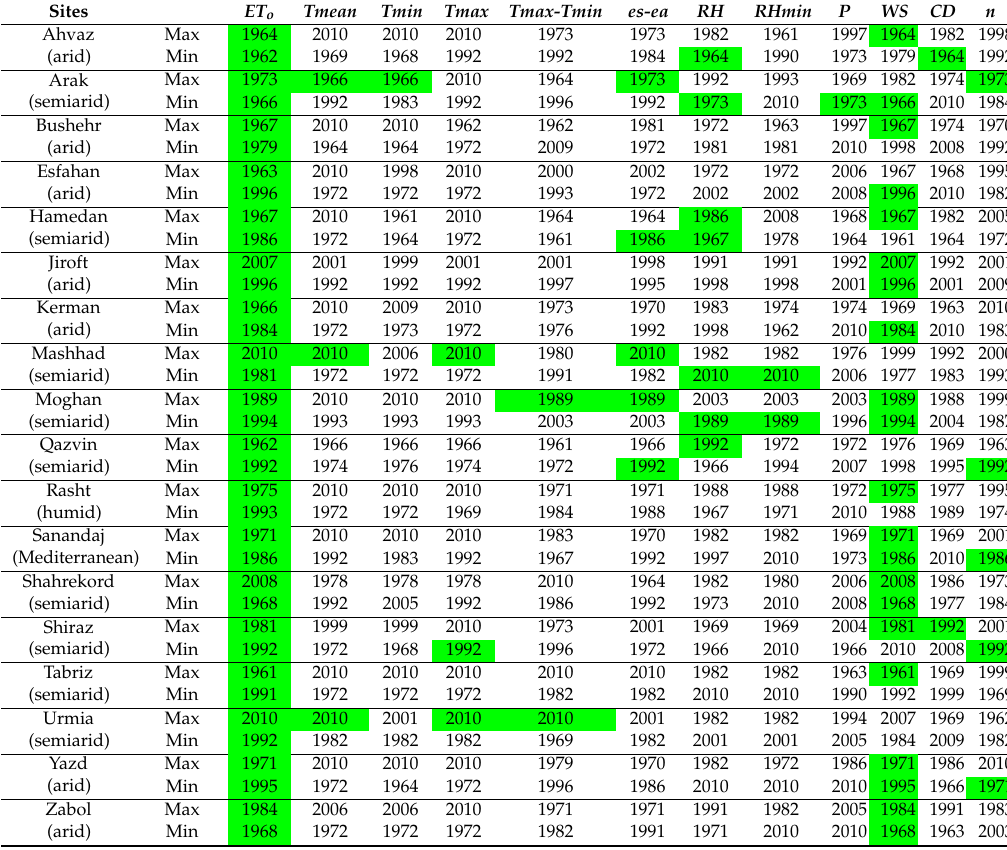
Table 4. The years of occurrence of maximum and minimum values of ET o and meteorological variables in each study site during the 50-year study period. If the annual extremum values of ET o and a particular meteorological variable coincide, they are highlighted in green